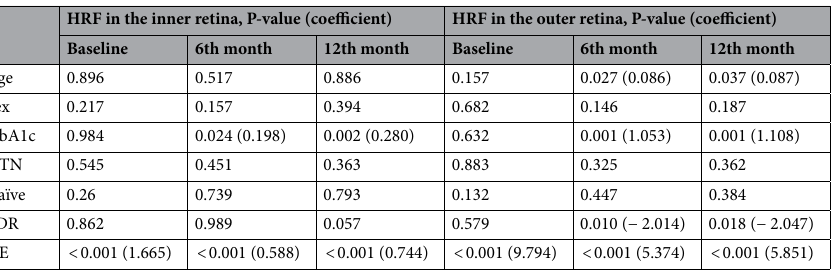
Table 4. The coefficient and P-value in the linear regression model for possible associated baseline characteristics of the number of HRF in the inner and outer retina at different time points. The coefficient of significant factors (p-value < 0.05) is shown within the brackets. HbA1C haemoglobin A1C, HTN hypertension, PDR proliferative diabetic retinopathy, HE hard exudate.